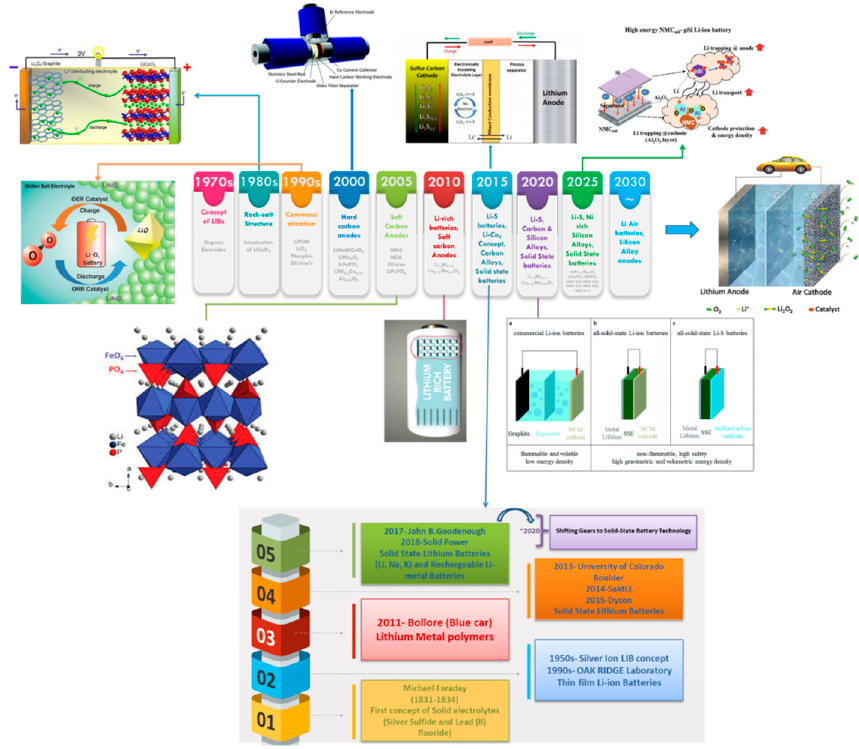
Figure 1. Historical evolution and advances of Lithium-ion battery technologies.